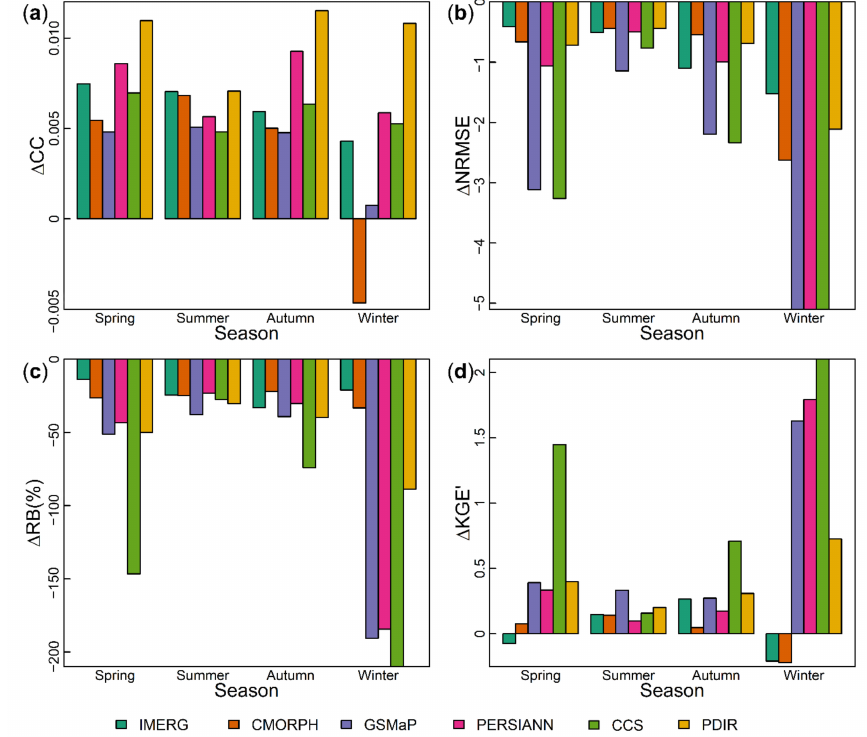
Figure 5. Seasonal variations of ( a ) ∆ CC, ( b ) ∆ NRMSE, ( c ) ∆ RB(%), and ( d ) ∆ KGE (cid:48) for six